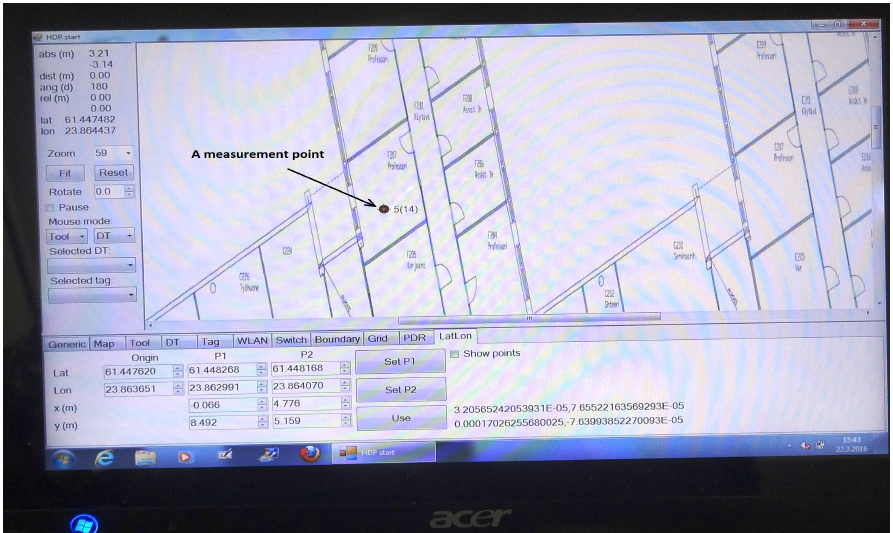
Figure 2. The Acer windows tablet used for collecting data with a sample measurement point shown here. The number outside the parentheses (here, 5) is the fingerprint index, and the number inside (here, 14) shows the number of access points heard in this